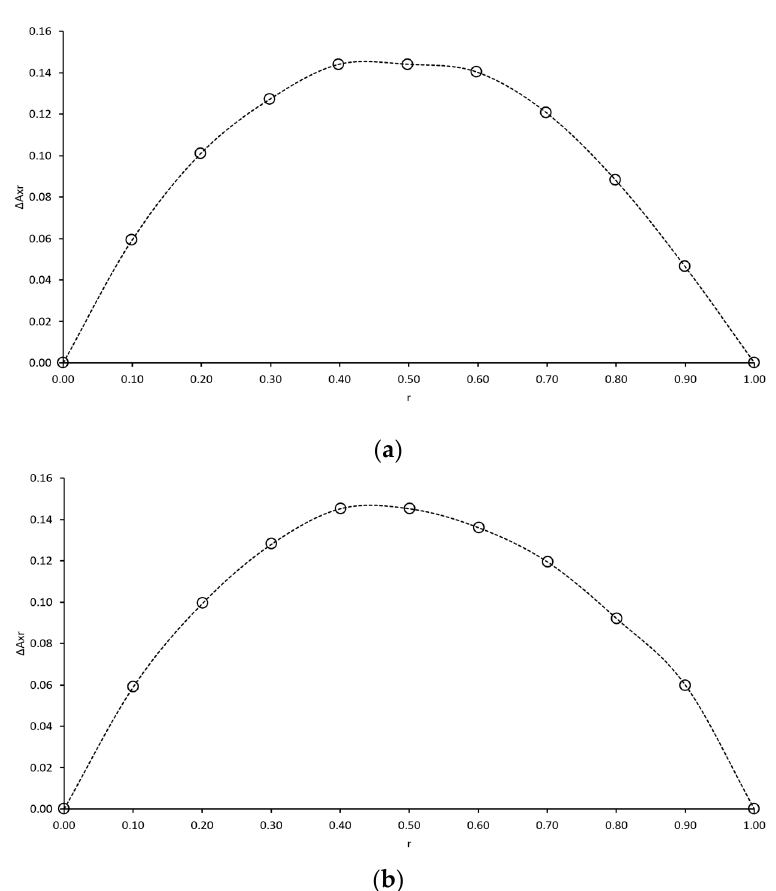
Figure 1. Job’s plots corresponding to the ascorbic acid (AA)/ γ -cyclodextrin ( γ CD) ( a ) and AA/ Poly(vinyl alcohol) (PVA) ( b ) complexes at λ = 265 nm.